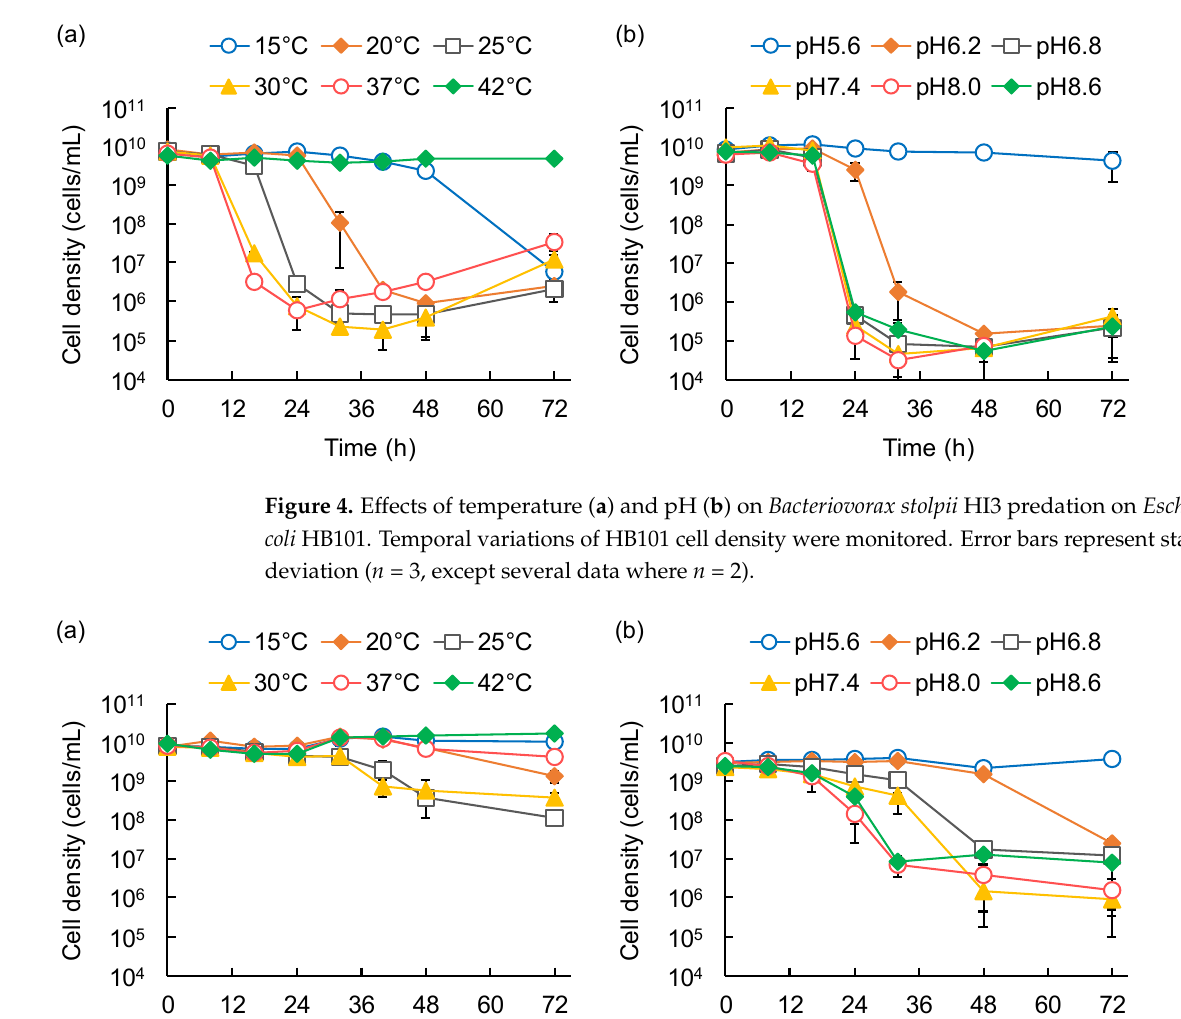
Figure 4. Effects of temperature ( a ) and pH ( b ) on Bacteriovorax stolpii HI3 predation on Escherichia coli HB101. Temporal variations of HB101 cell density were monitored. Error bars represent standard deviation ( n = 3, except several data where n = 2).